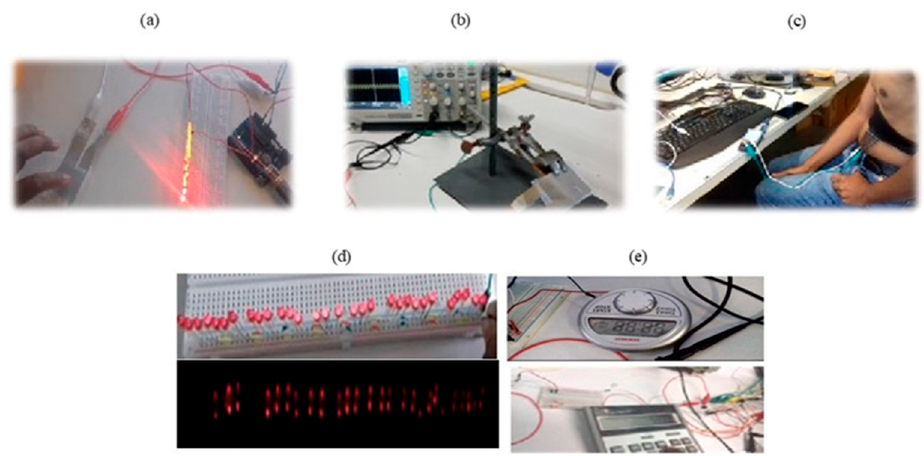
Figure 8. Demonstration of the PSTS as ( a ) a touch sensor; ( b ) water droplets for voltage generation; ( c ) breathing detection; ( d ) a PSTH lightening 32 LEDs in the dark ( bottom ) and at daylight ( top ); and ( e ) stored energy powering electronics such as a timer and calculator in operation.